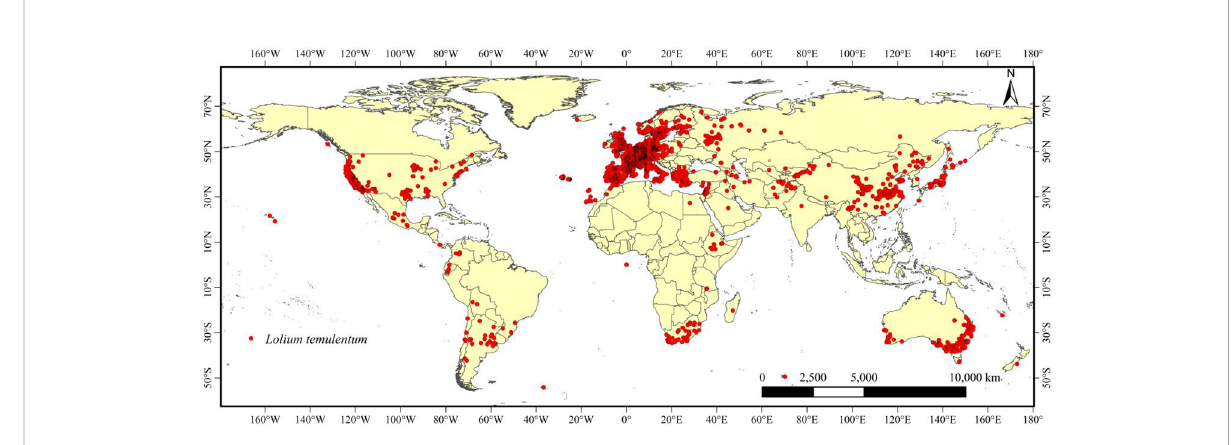
FIGURE 1 Global distribution points for Lolium